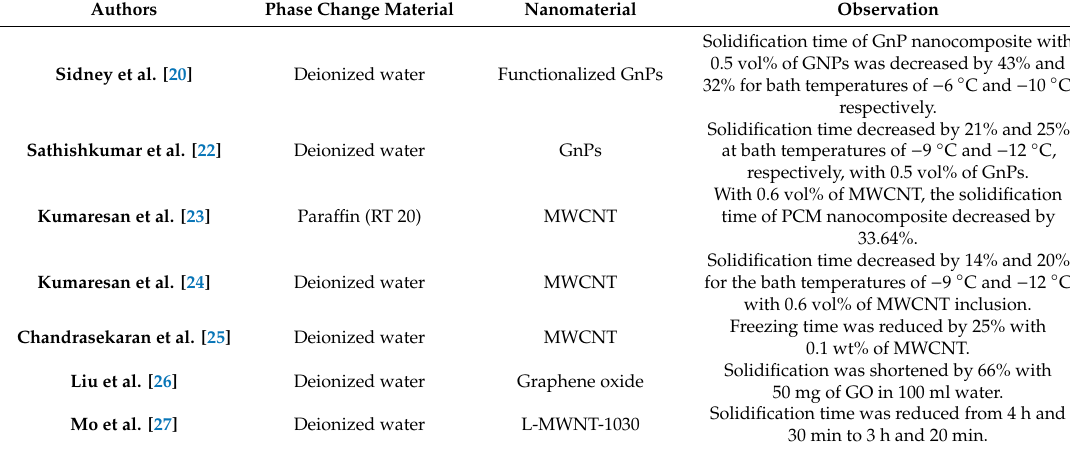
Table 1. Recent studies on the solidification of PCM nanocomposites with carbon-based nanomaterials for cold TES